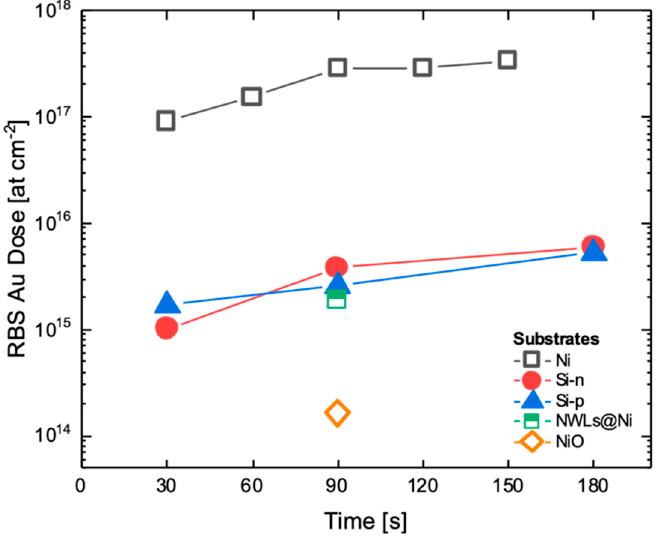
Figure 4. Comparison of Au dose extracted by RBS for different substrates at increasing immersion Figure4. ComparisonofAudoseextractedbyRBSfordi ff times.